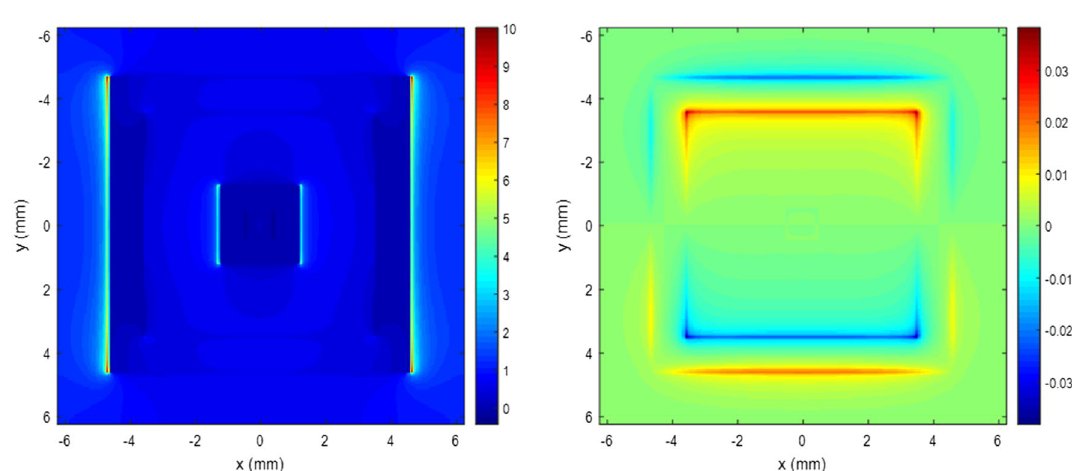
Figure 2. Electric and magnetic field distributions of a double square loop pattern at 5.7